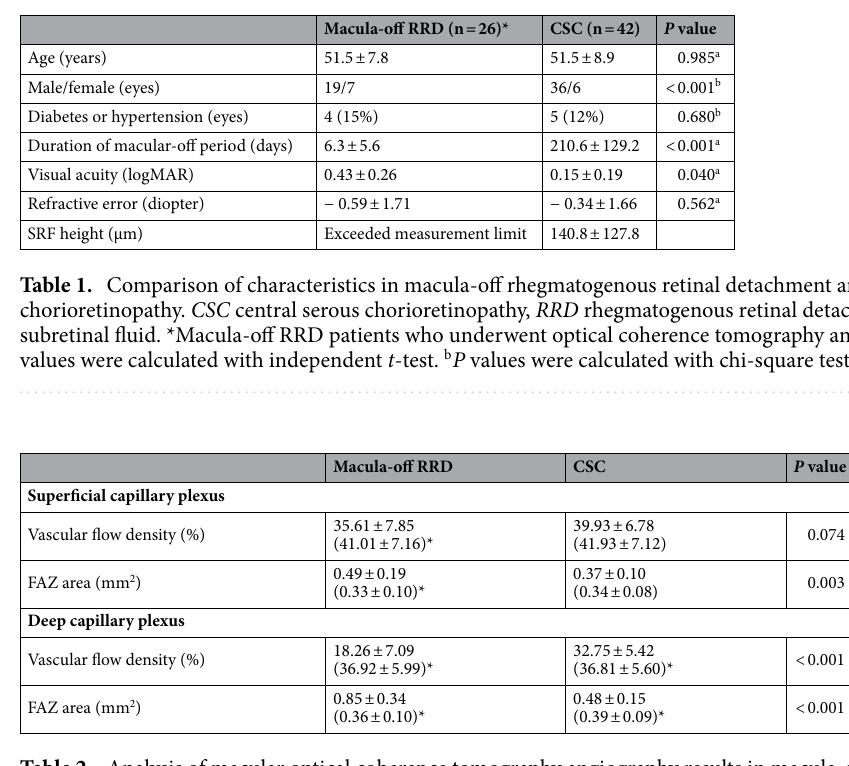
Table 2. Analysis of macular optical coherence tomography angiography results in macula-off rhegmatogenous retinal detachment (and fellow eye) and central serous chorioretinopathy (and fellow eye). Values of the control group (normal fellow eyes) are presented in parentheses. RRD rhegmatogenous retinal detachment, CSC central serous chorioretinopathy, FAZ foveal avascular zone. * P values comparing RRD or CSC and the fellow eye <